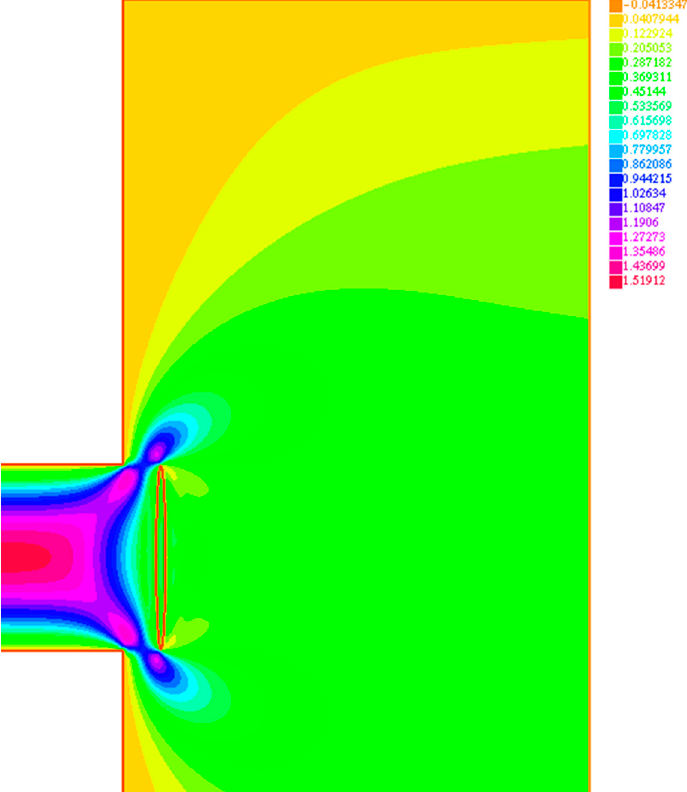
Figure 8. Case b: valve operative condition with h = 10 mm, with velocity vertical component v .